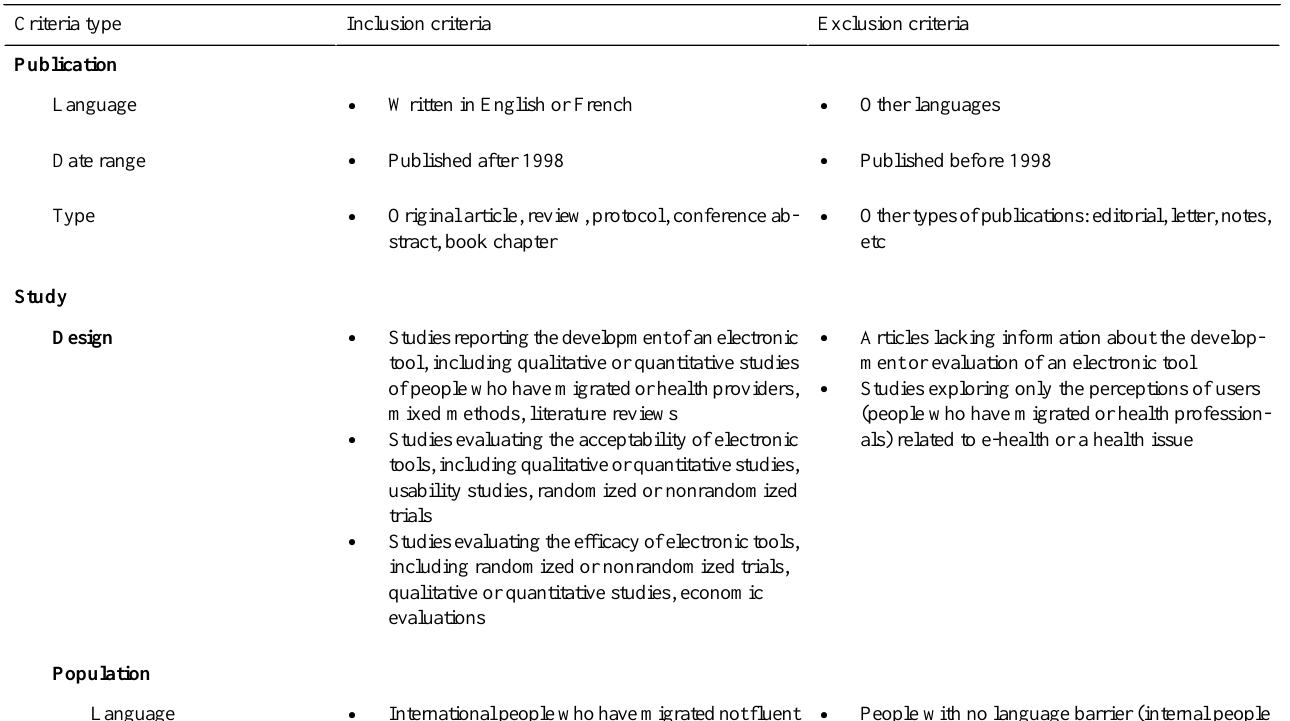
Table 1. Inclusion and exclusion